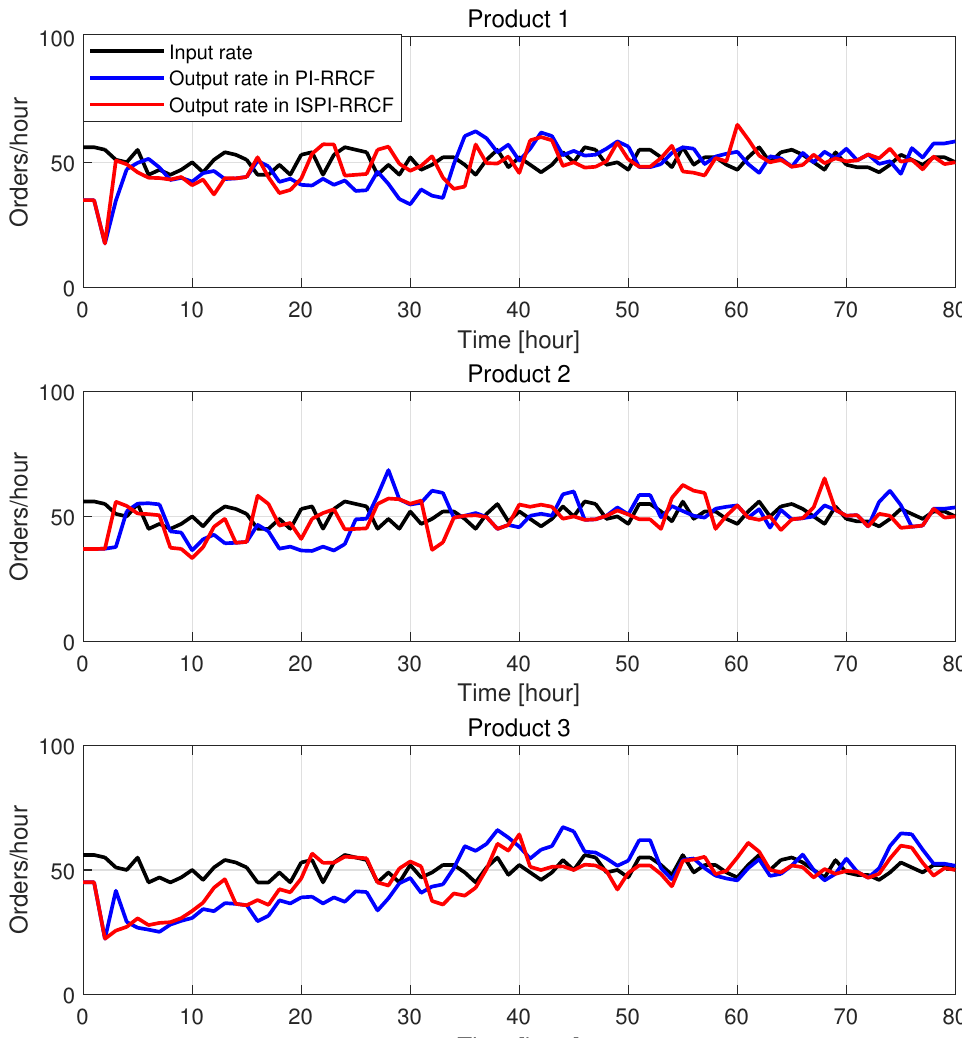
Figure 10. Dynamic performance of the